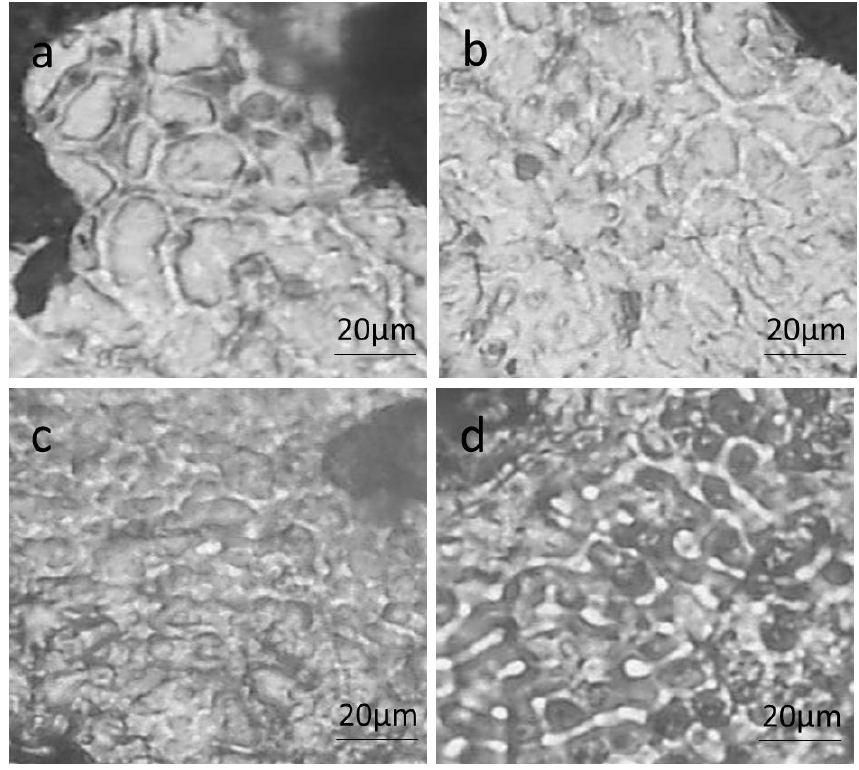
Figure 2. Optical microstructure of Mg-Zn alloys: ( a ) Mg-2Zn; ( b ) Mg-4Zn; ( c ) Mg-6Zn; and ( d ) Mg-8Zn.